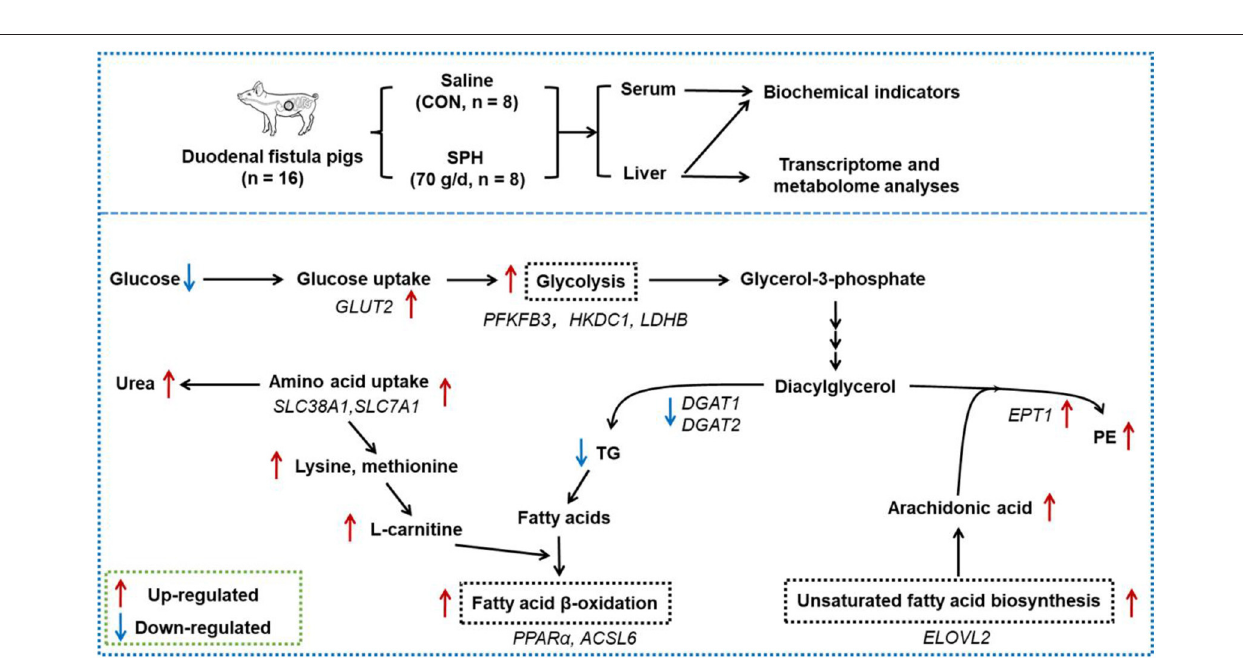
FIGURE 4 | Effects of the duodenal infusion SPH on liver metabolism. The red arrows represent the up-regulated level of genes and metabolites in the SPH group compared to the control (CON) group; the blue arrows represent the down-regulated level of genes and metabolites in the SPH group compared to the CON